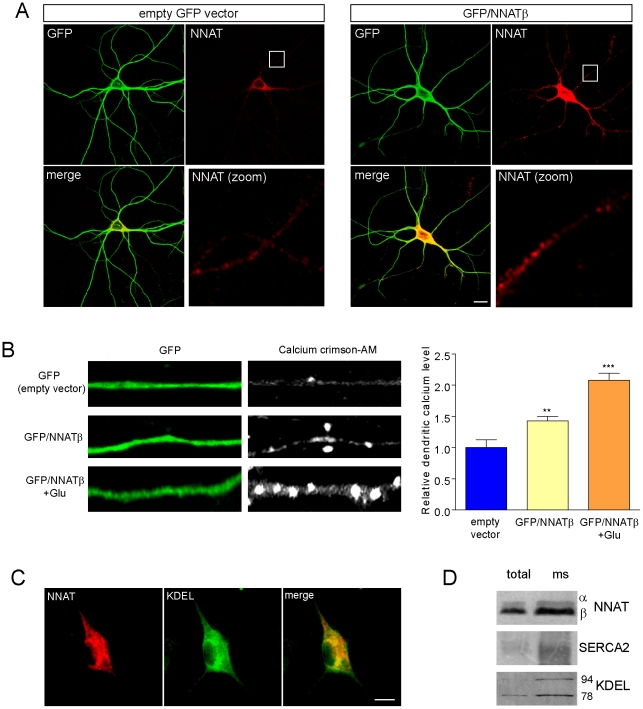
NNATβ overexpression results in elevated dendritic Ca2+.(A) Neurons were transfected with the empty GFP vector (left) or the dual expression GFP/NNATβ (right), allowed to express for 8 hrs, and immunostained for NNAT (red) and GFP (green). Scale bar: 10 µm. (B) Left, neurons transfected with empty vector or GFP/NNATβ were loaded with Calcium Crimson-AM, and dendritic GFP and Calcium Crimson signals were acquired. GFP/NNATβ transfected cells were also treated with 40 µM glutamate (5 min) following Calcium Crimson loading to further induce Ca2+ levels. Calcium Crimson signal was grayscaled to enhance contrast. Values expressed as ratios of Calcium Crimson normalized to GFP fluorescence (empty vector, n = 12 dendrites, 4 neurons; GFP/NNATâ, n = 12 dendrites, 6 neurons; GFP/NNATβ+Glu, n = 10 dendrites, 5 neurons, **p<0.01, ***p<0.001). Experiments were performed using 2 independent batches of cultures. (C) NNAT is localized to the endoplasmic reticulum (ER). Cultured neurons co-immunostained with NNAT (red) and an ER marker against KDEL (green). Scale bar: 5 µm. (D) NNAT is 1.8-fold enriched in microsomes (ms) generated from hippocampi compared to total protein. Microsome enrichment was assessed using antibodies against ER markers Grp94 (2.1-fold enrichment), Grp78 (2.7-fold enrichment), and SERCA2 (3.0-fold enrichment).